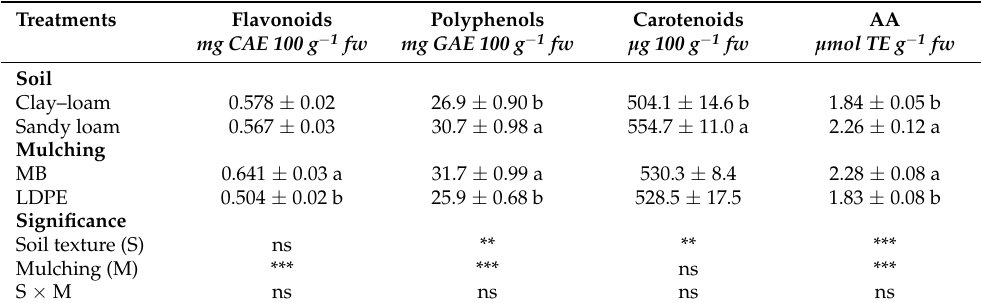
Table 2. Effect of soil texture (clay–loam—CL; sandy loam—SL) and mulching (biodegradable film— MB; low density polyethylene—LDPE) on flavonoids, polyphenols, carotenoids, and total antioxidant activity of muskmelon fruits.